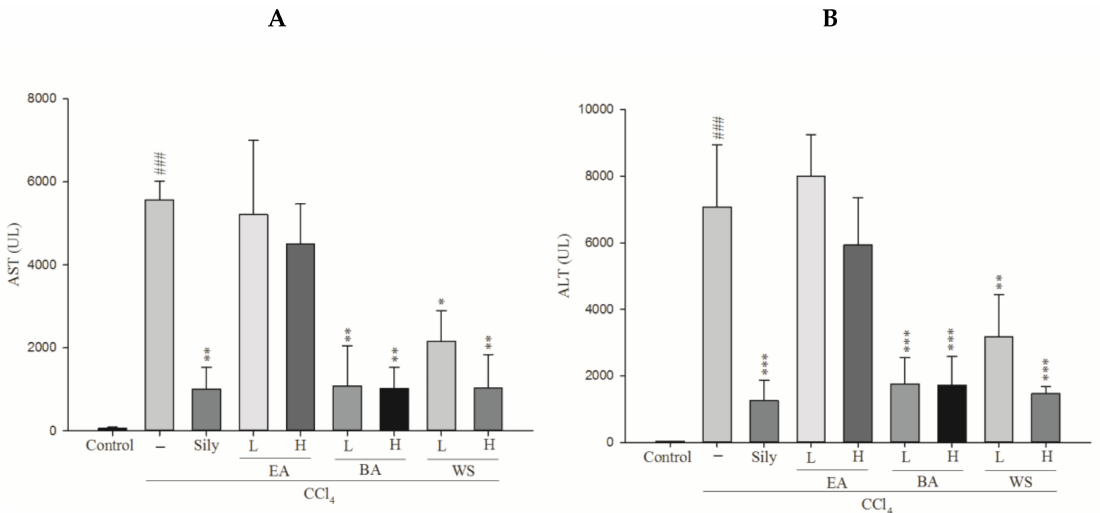
Figure 1. Effect of different fractions of black garlic and silymarin on serum ( A ) AST ( B ) ALT activities in mice treated with CCl 4 . Each value was represented as mean ± S.E.M. ( n = 10). ### p < 0.001 as compared with the control group. * p < 0.05, ** p < 0.01, *** p < 0.001 as compared with the CCl 4 group (one-way ANOVA followed by Scheffe’s multiple range test).